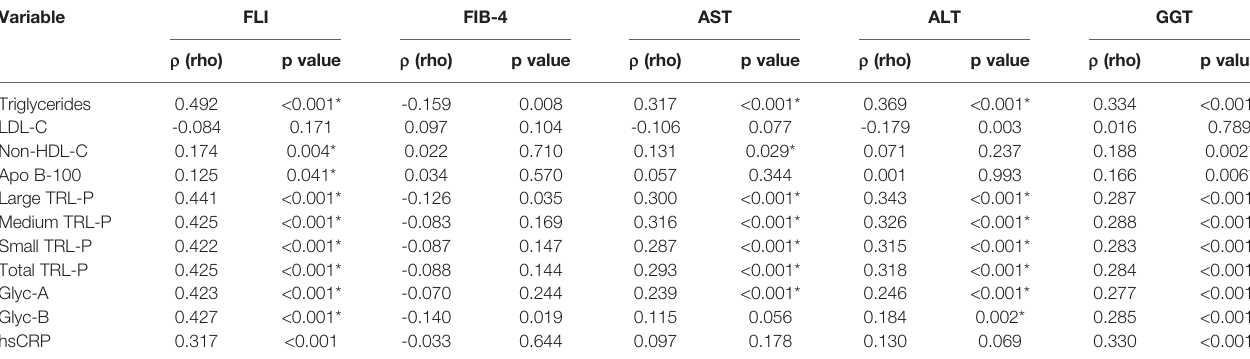
Spearman correlation coef fi cients (rho) and signi fi cance (P-values). *Remained signi fi cance after adjustment for sex, age and BMI.